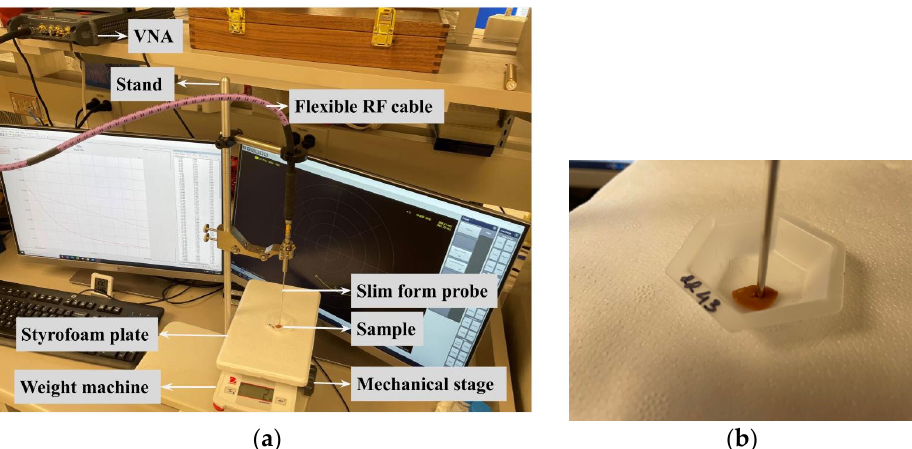
Figure 1. ( a ) Laboratory setup for the dielectric spectroscopy measurements using opened